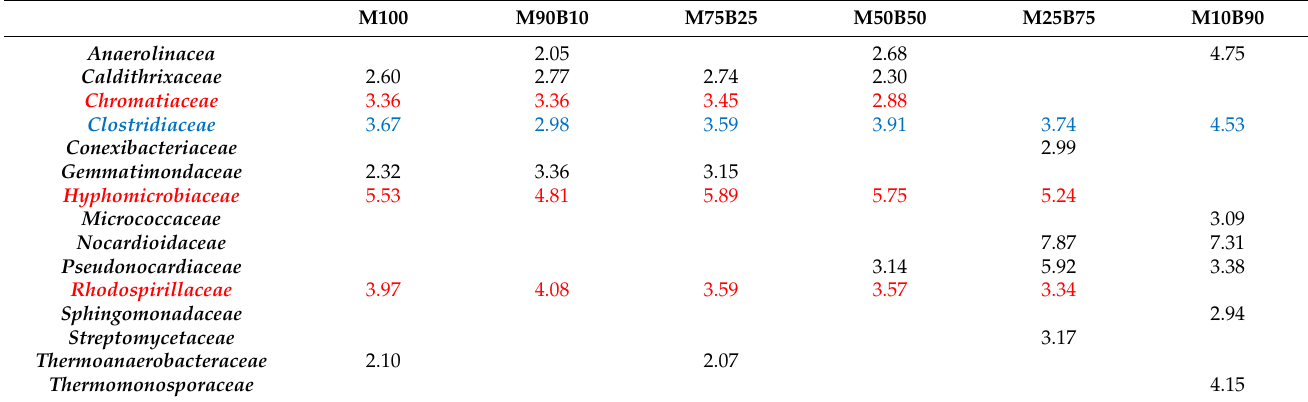
Table 7. Family classification for mud compost (M) blended with biochar (B) by percent of total nucleic acids in the sample metagenome.